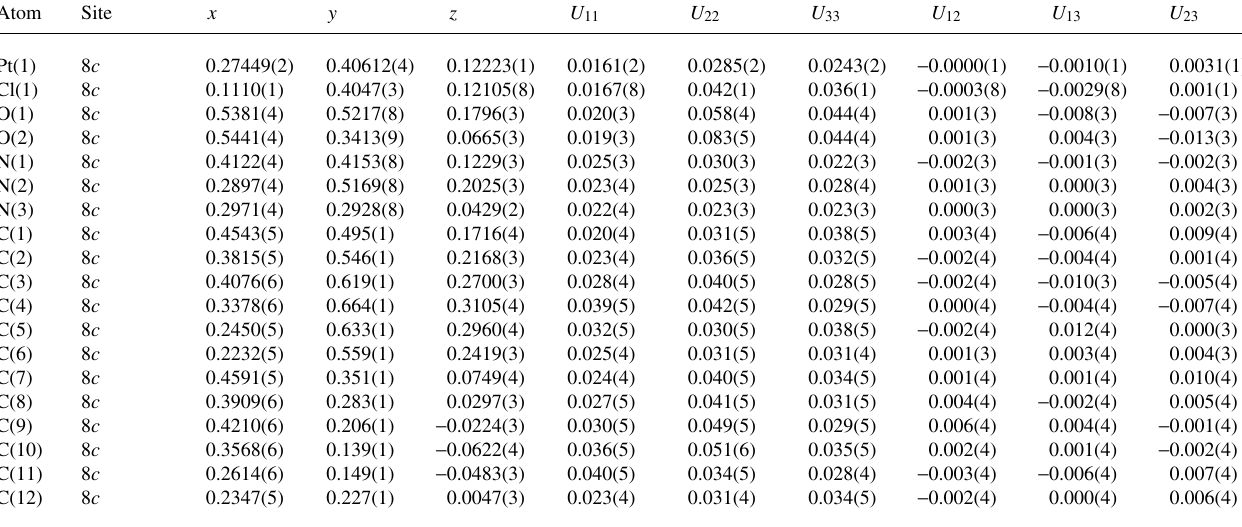
Table 3. Atomic coordinates and displacement parameters (in Å 2 ) .